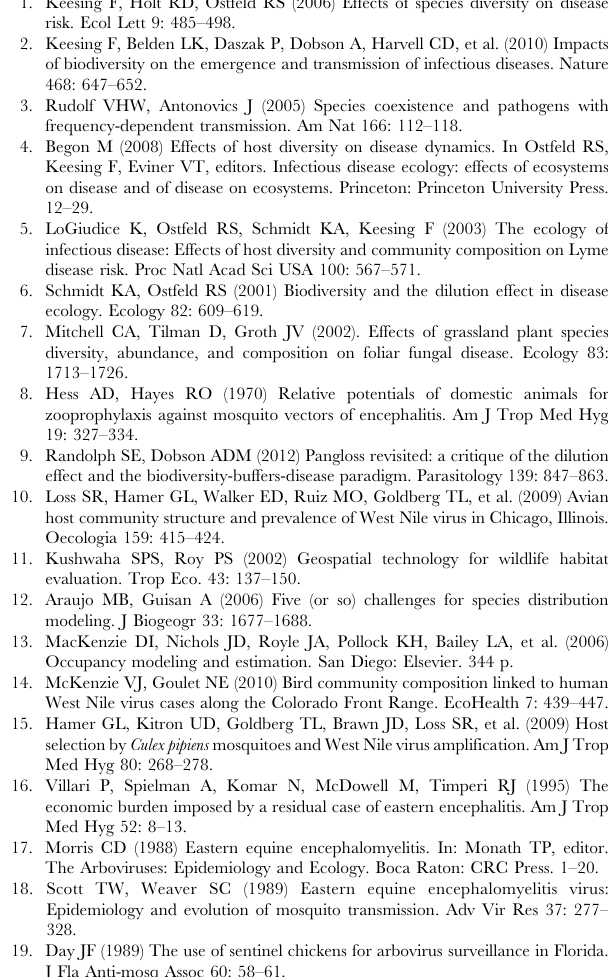
Table S2 Estimates of Culiseta melanura abundances derived from mosquito sampling from April to mid-